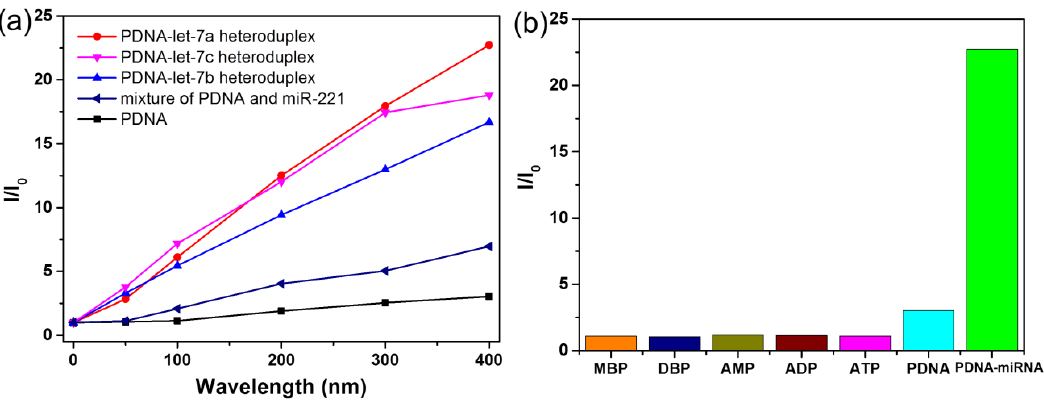
Figure 4. ( a ) Plot showing fluorescence intensity changes of EB-TAPB-TFP NSs from 606 nm to 625 nm with increasing concentrations of PDNA, mixture of PDNA and miR-221, PDNA-let-7b heteroduplex, let-7c heteroduplex and let-7a heteroduplex, from down to up. ( b ) Plot showing selective fluorescence enhancement ( λ ex = 350 nm) of EB-TAPB-TFP NSs upon adding MBP, DBP, AMP, ADP, ATP, PDNA and PDNA-miRNA heteroduplex.